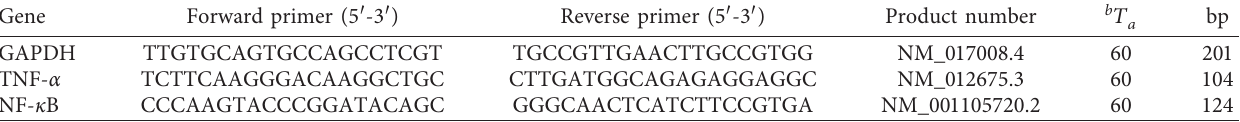
Table 1: Oligonucleotide primer sequences used in conducting qRT-PCR of TNF- α and NF-kB gene expression protocol. Gene Forward primer (5 ′ -3 ′